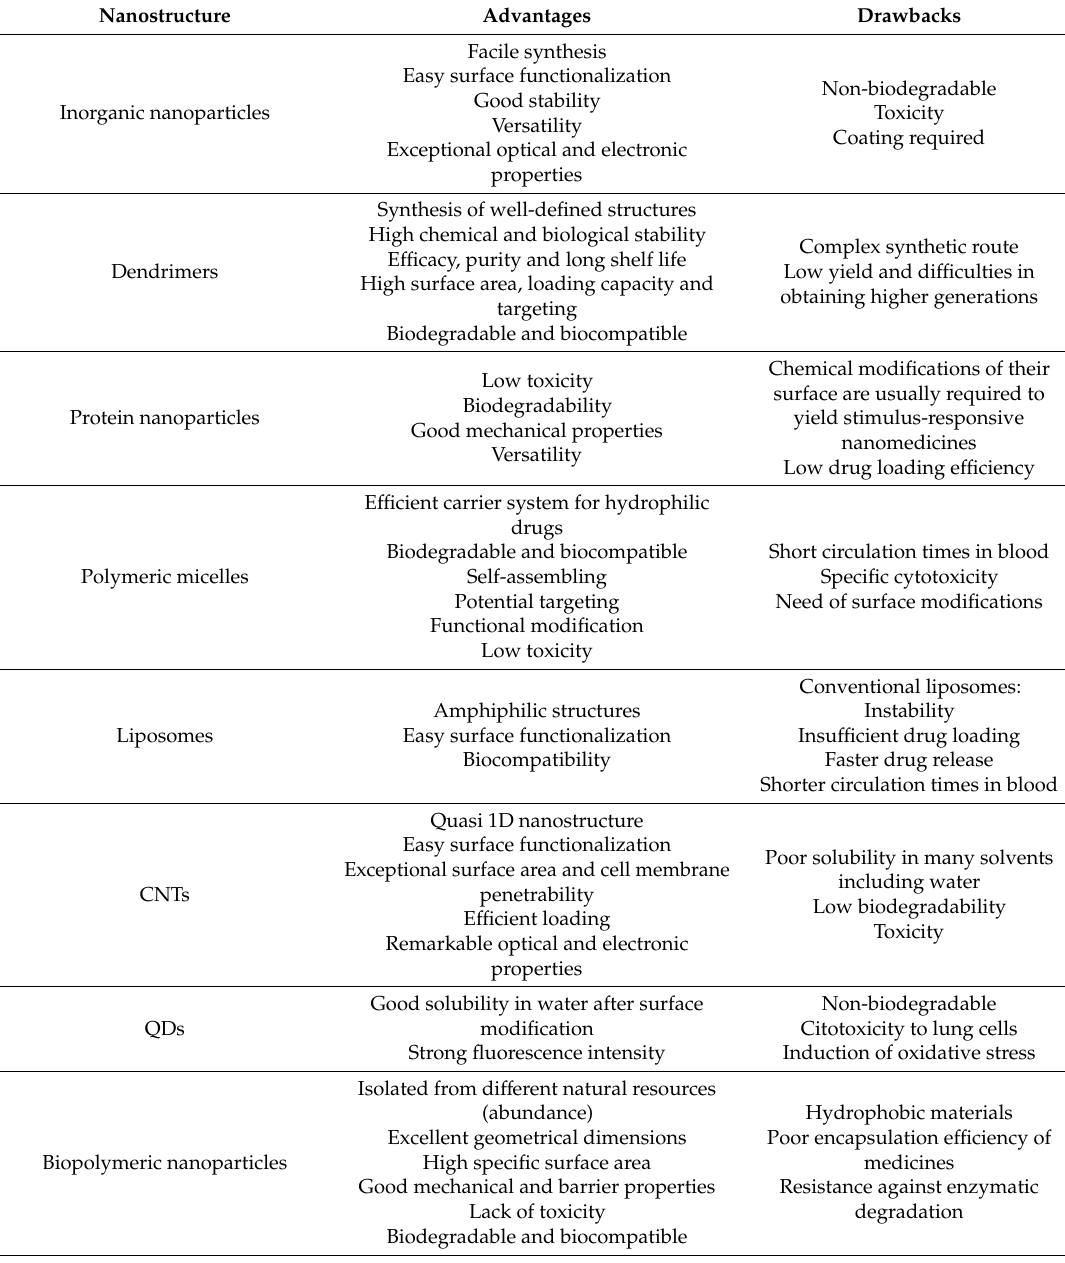
Table 1. Advantages and drawbacks of